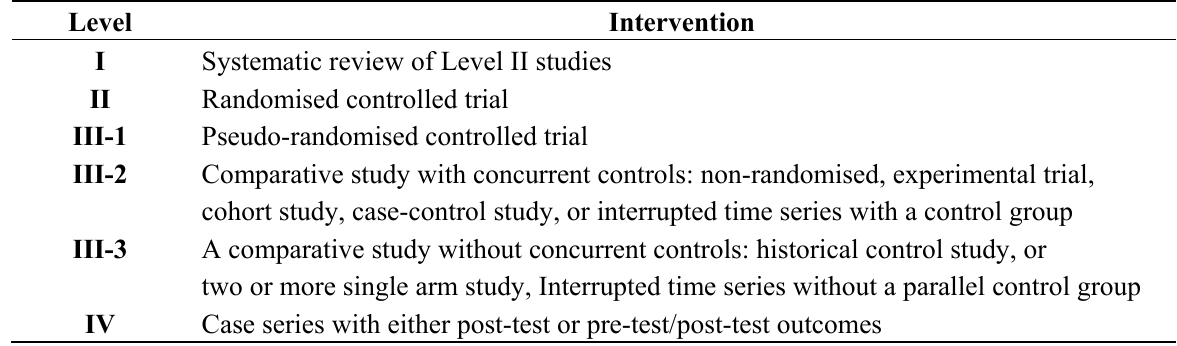
Table 1. Australian National Health and Medical Research Council (Australia) Evidence Hierarchy: designations of “levels of evidence”